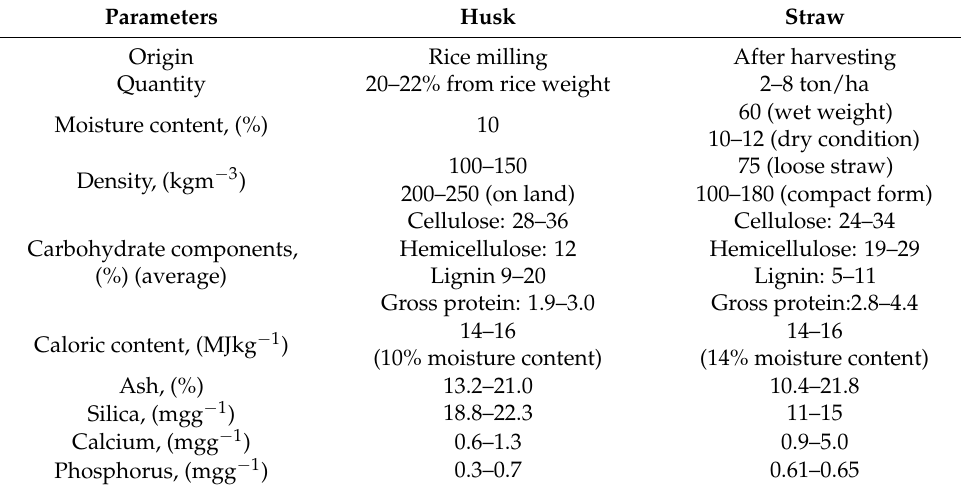
Table 4. Characterization and structural analysis of the husk and straw [66,67].